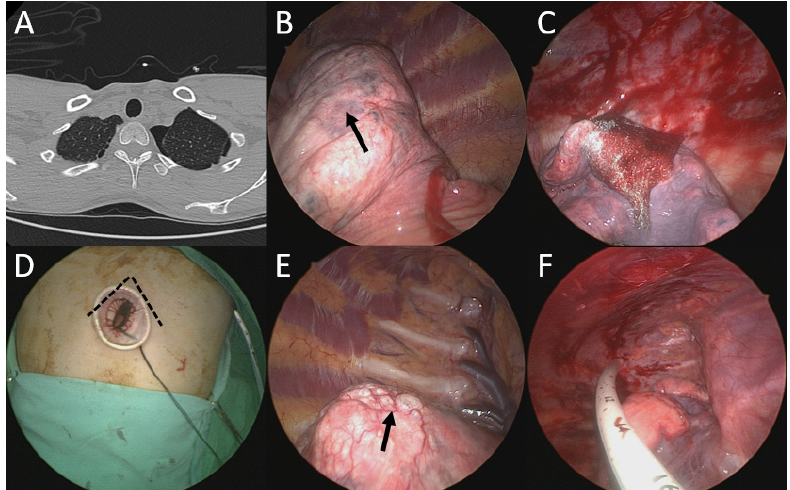
Figure 2. A patient with left PSP and right contralateral blebs underwent simultaneous uniportal left intercostal and right subxiphoid VATS wedge resection and pleurodesis. ( A ) Computed tomography scan showed left PSP and right contralateral blebs. ( B ) Emphysema-like changes observed over left upper lobe (arrowhead). ( C ) After left upper lobe wedge resection and staple lines covered with reinforcement felt. ( D ) Uniportal subxiphoid VATS for right side procedure. ( E ) Right upper lobe blebs observed (arrowhead). ( F ) Chest drain the same size as used on the other side was placed through the subxiphoid incision. PSP, primary spontaneous pneumothorax. VATS, video-assisted thoracoscopic